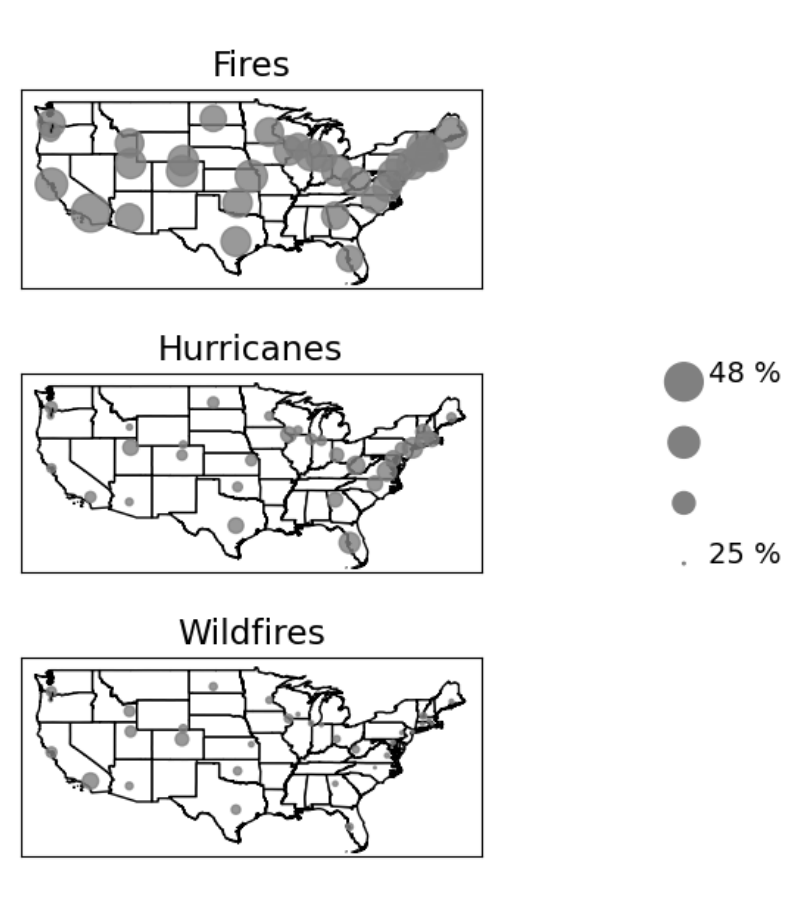
Figure A1. Percent of relevant articles per source. An article was deemed relevant if it contained a